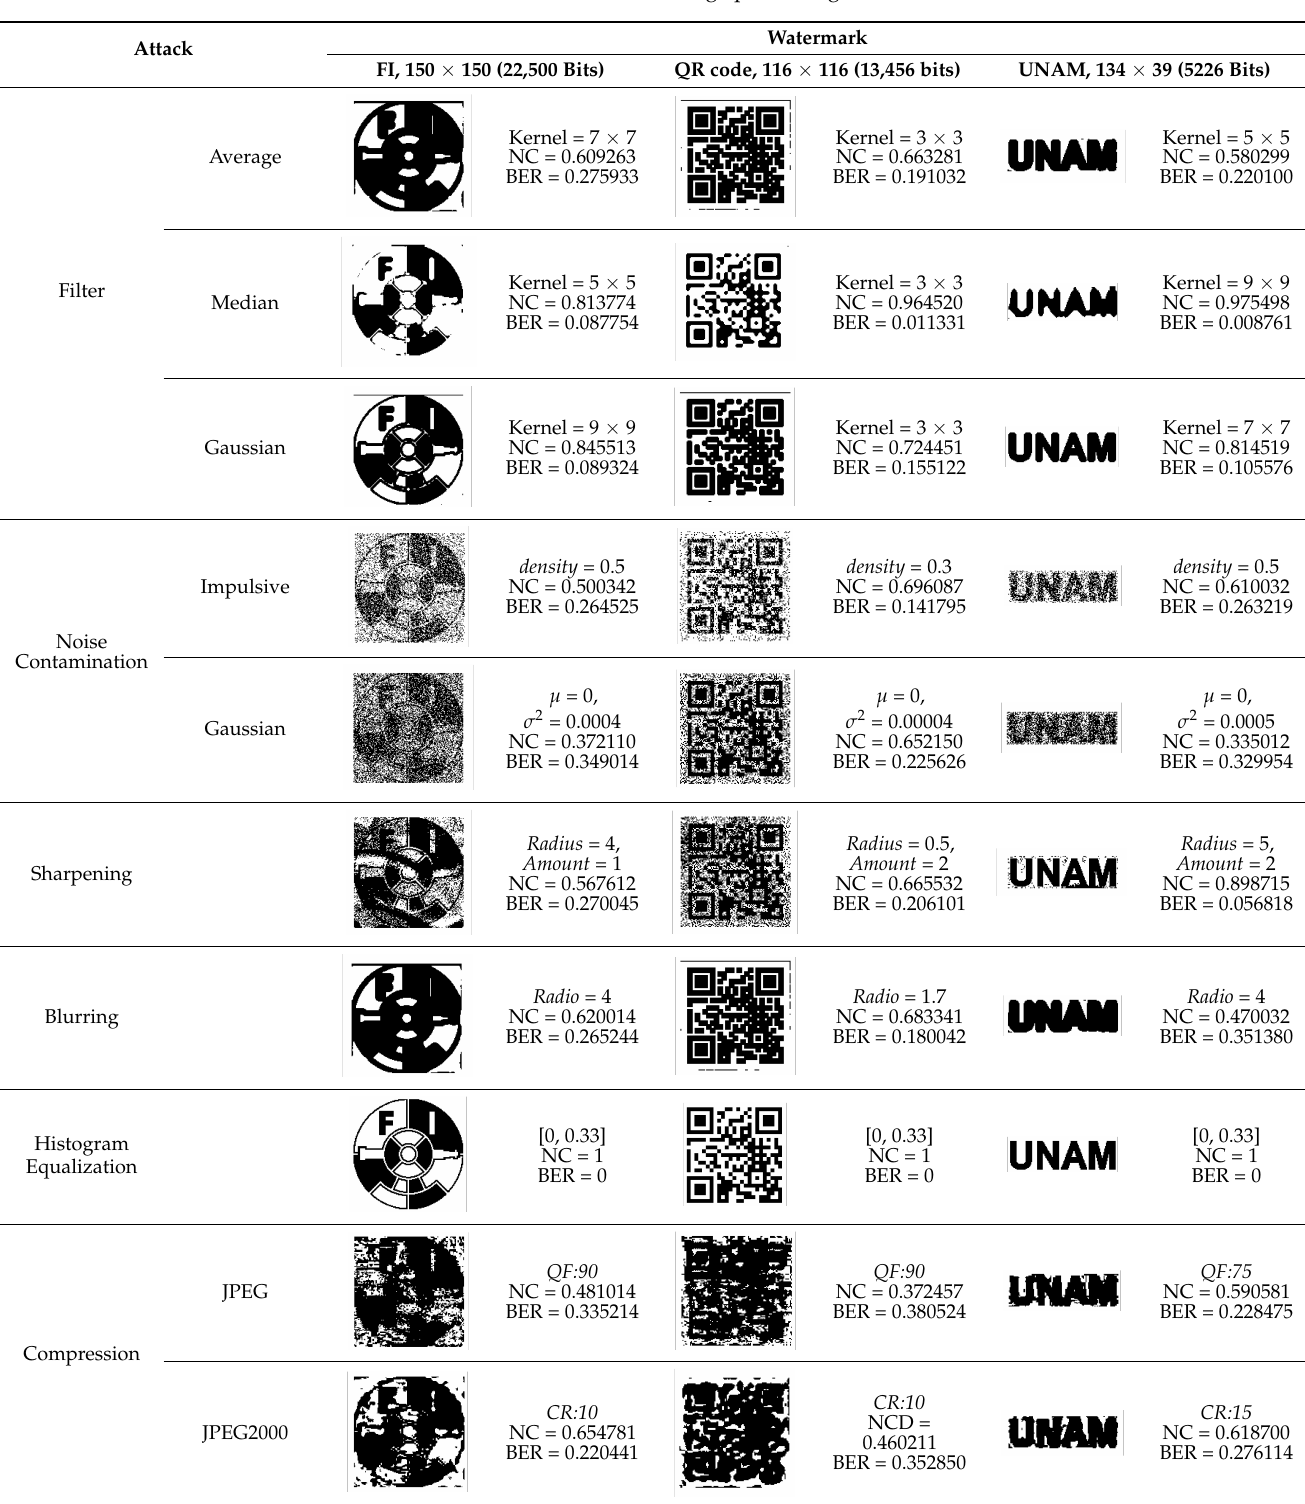
Table 8. Results of common image processing